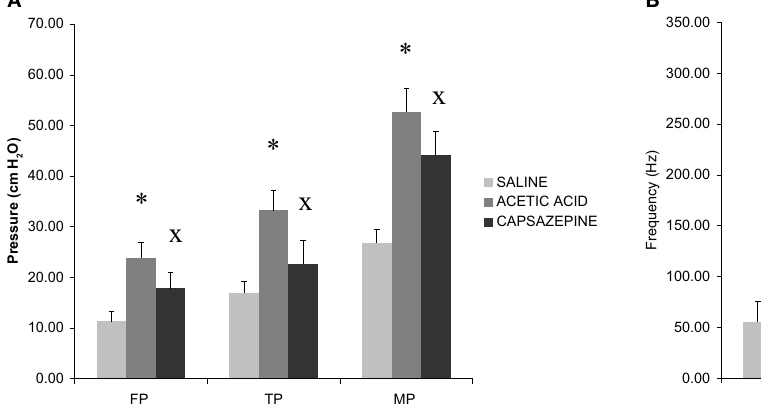
changes in sensory activity during filling, threshold, and micturition phases. A significant increase in all three parameters was observed following the infusion of 0.5% acetic acid. Capsazepine, infused with 0.5% acetic acid, significantly reduced sensory nerve activity recorded during filling and threshold phases. The (*) mark a significant difference between 0.9% NaCl and 0.5% acetic acid, ( x ) indicate significant difference between 0.5% acetic acid and capsazepine.